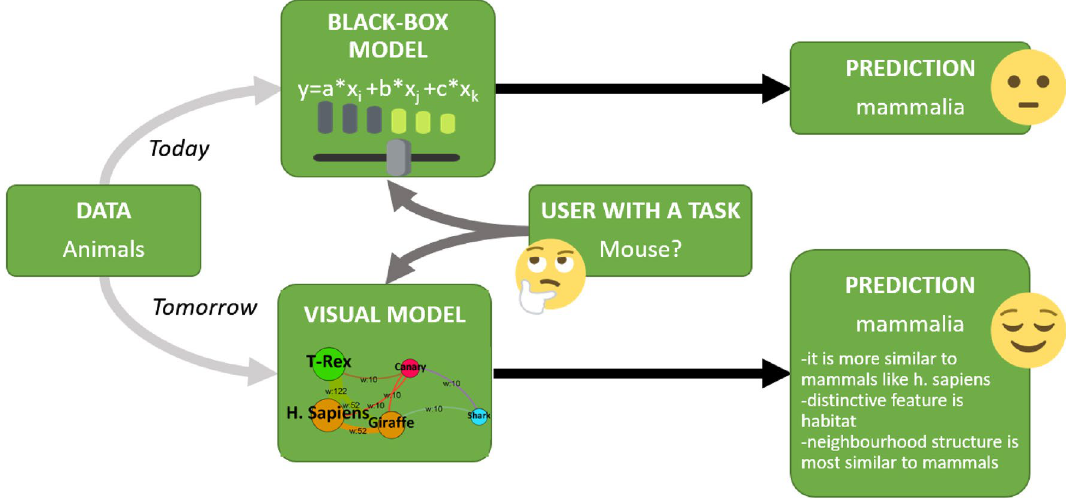
Figure 7. Explainable AI approach versus todays’ classifier models in a